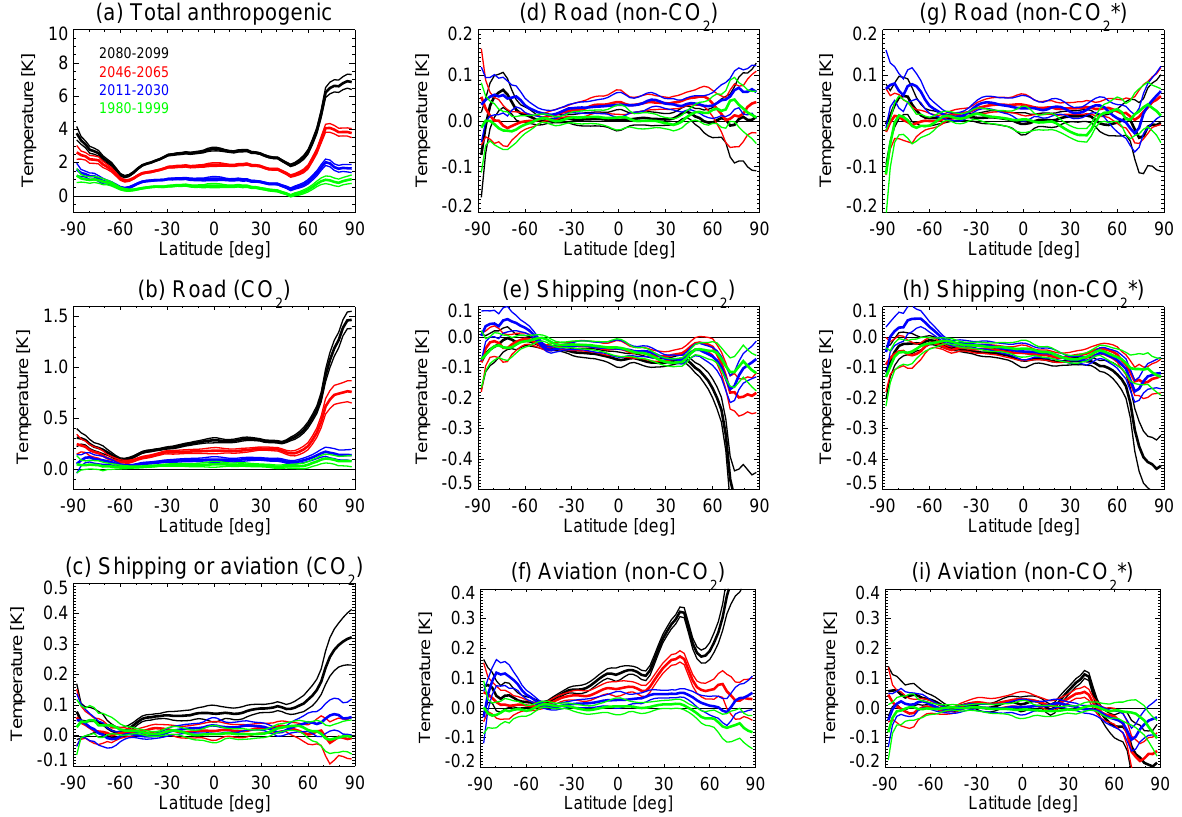
Fig. 11. Annual zonal mean surface air temperature impact in 1980–1999 (green), 2011–2030 (blue), 2046–2065 (red) and 2080–2099 (black): (a) total anthropogenic impact, CO 2 impact from (b) road transport and (c) shipping or aviation, non-CO 2 impact using the dynam- ical O 3 approach for (d) road transport, (e) shipping and (f) aviation, and non-CO 2 * impact using fixed O 3 approach for (g) road transport, (h) shipping and (i) aviation. Thick lines are the mean over the 3 members and thin lines indicate the 95 % confidence interval.